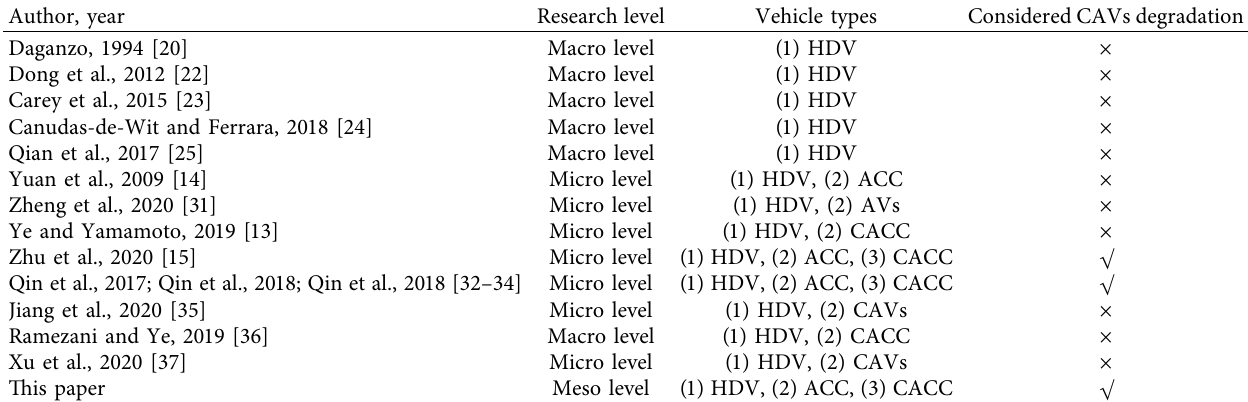
Table 1: Overview of traffic flow modeling and congestion